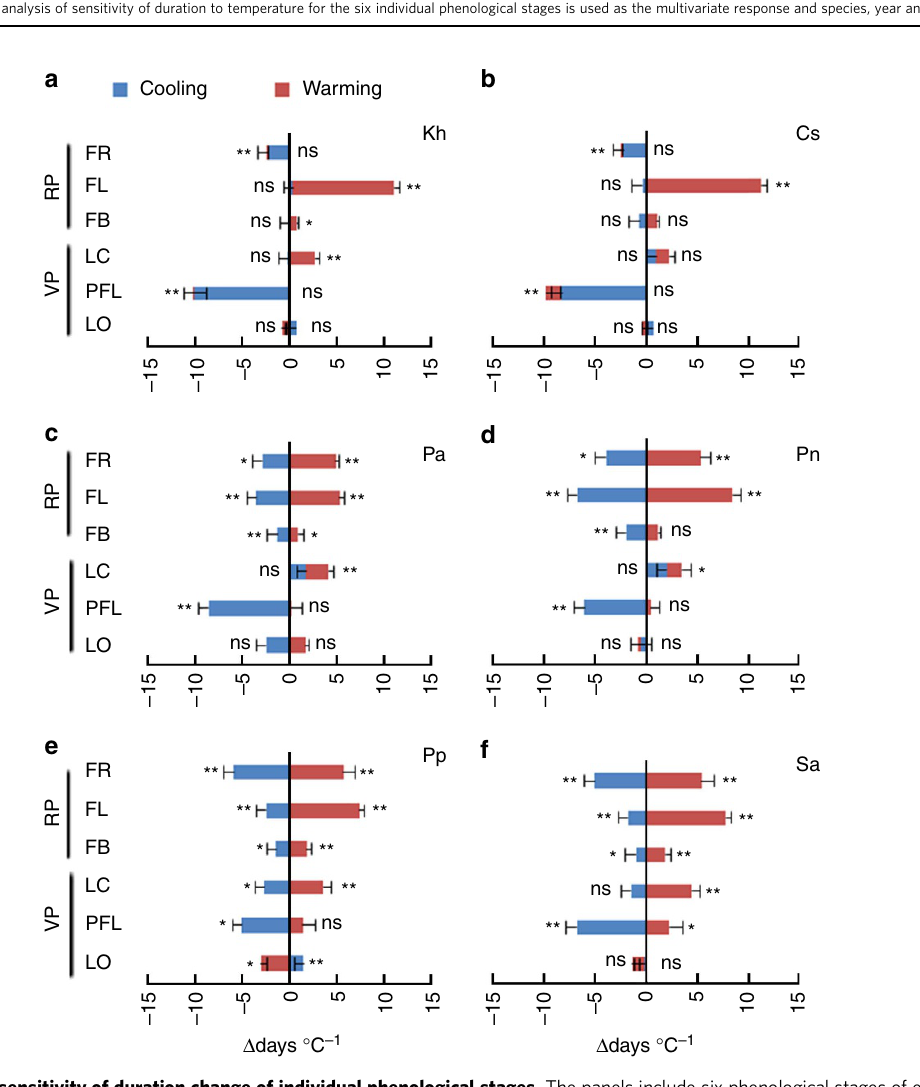
Correlations among phenological events . There were significant negative correlations between the sensitivity of the vegetative (VP) and reproductive phases (RP) to warming and cooling regardless of whether the analysis was pooled across all species (Table 4) or conducted separately for each species (Supplementary Tables 2–13; except for Pp (Supplementary NATURE COMMUNICATIONS|7:12489|DOI: